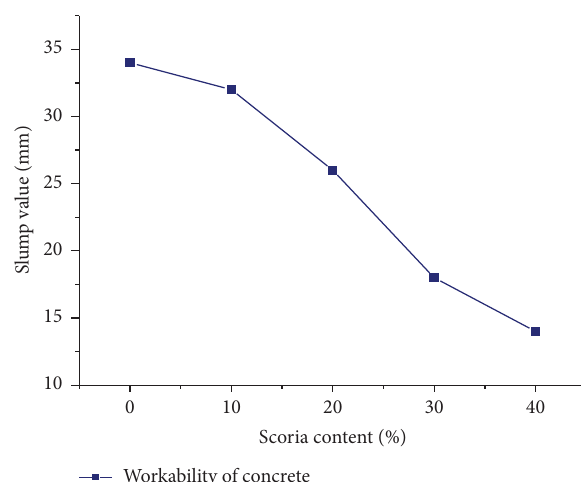
Figure 6: Graph of slump versus scoria content.